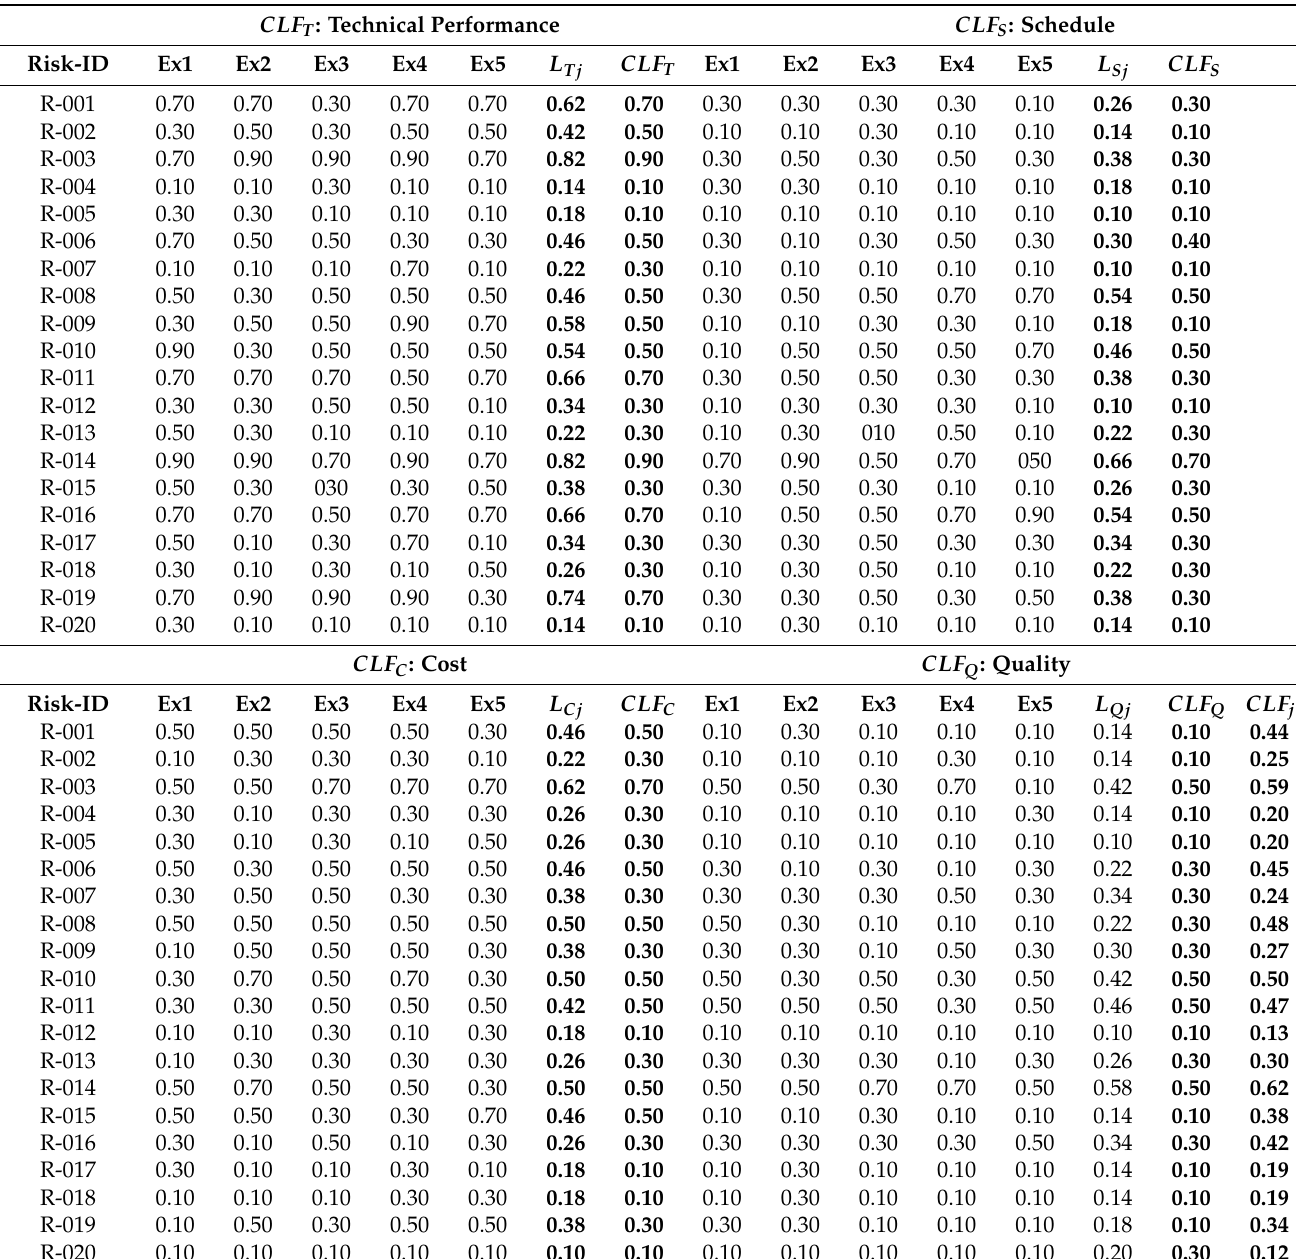
Table 9. Composite Likelihood Factors, CLF j .